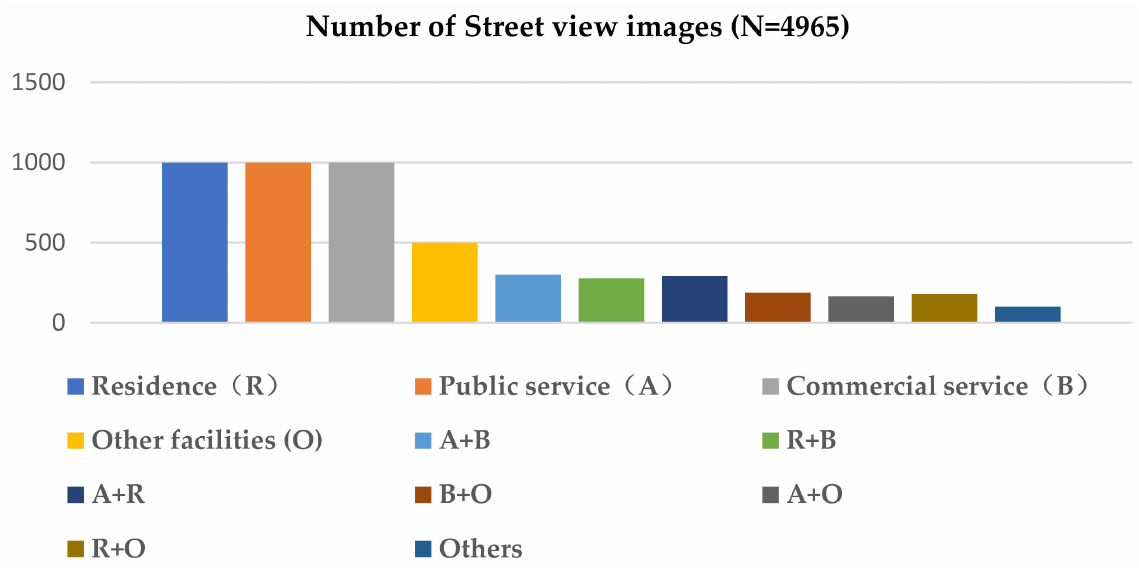
Figure 6. The number of training set images for each building